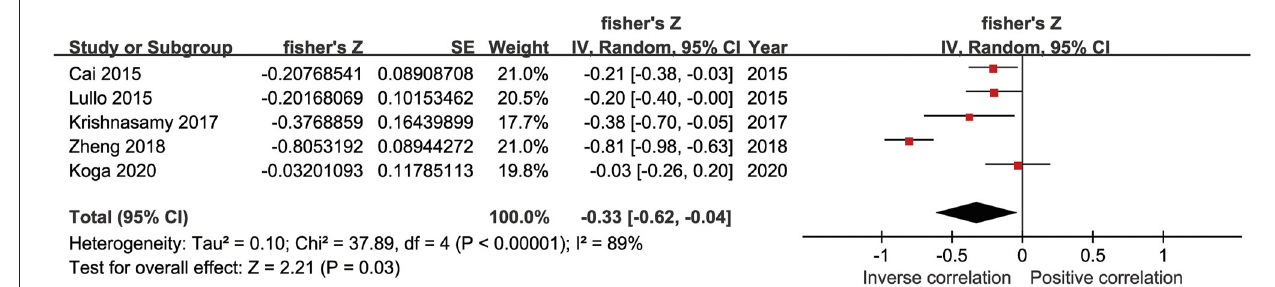
FIGURE 2 | Forest plots of the summary r for the association between sKlotho level and VC.